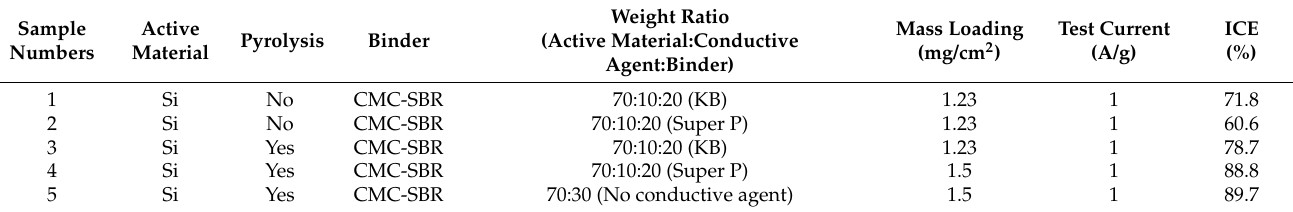
Table 2. Composition and respective electrochemical performance of silicon-based